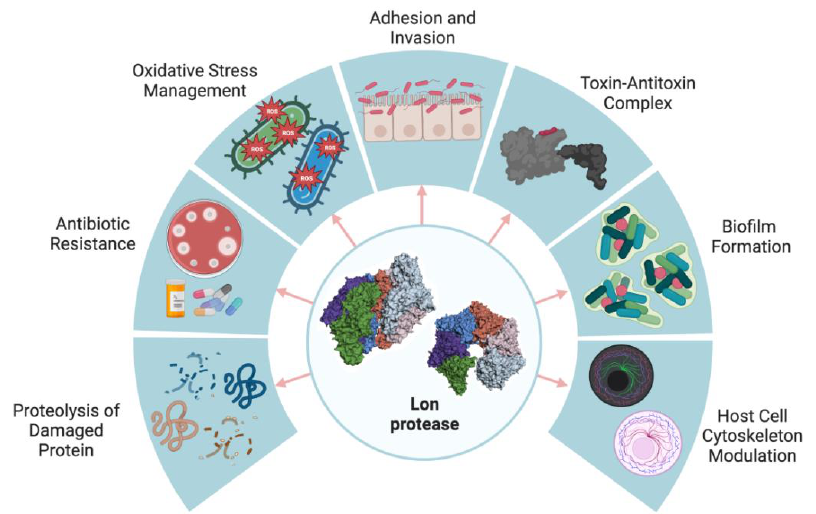
Figure 1. Lon protease regulates various functions in bacteria. Here, the hexamer form of the Lon protease is shown. The figure was created with BioRender.com.